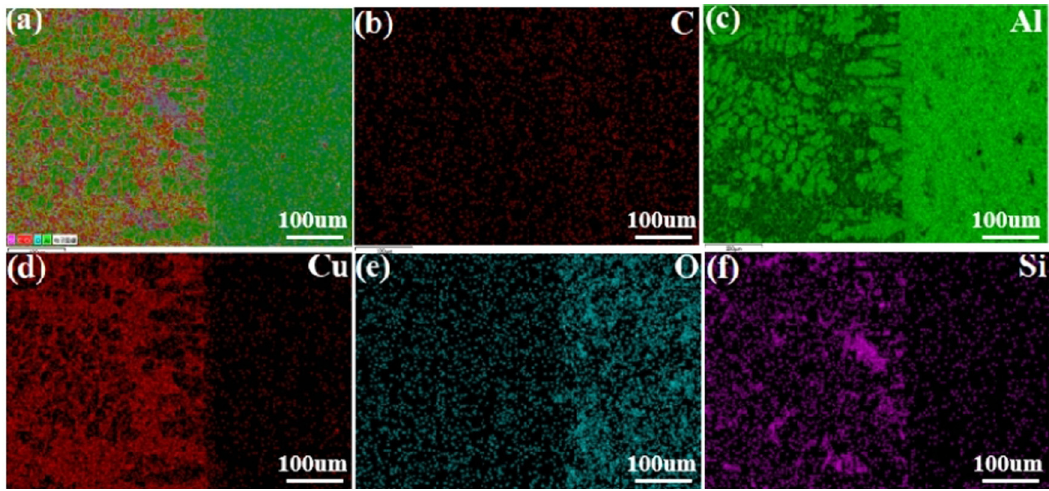
Table 2: Physical phase energy spectrum of BAl88Si solder brazing joint Measuring